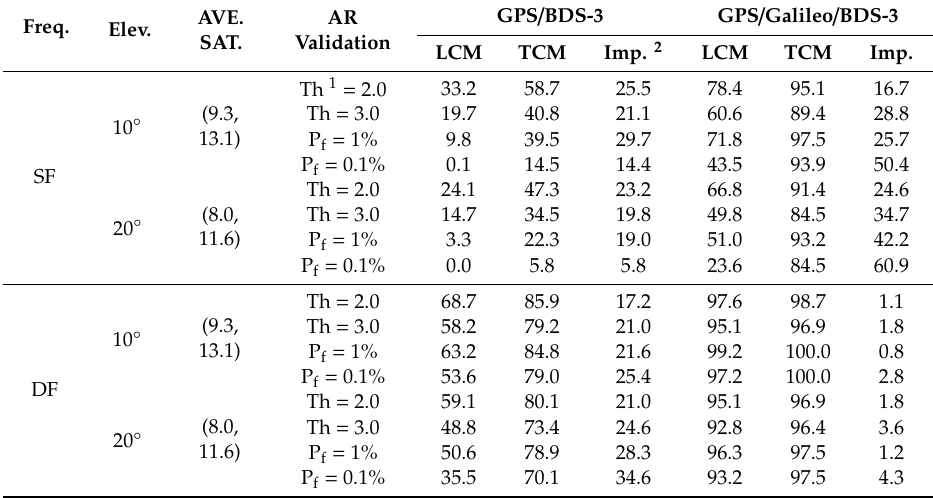
Table 5. Empirical ambiguity resolution success rates (percent) for GPS / BDS-3 and GPS / Galileo / BDS-3 solutions with 10 ◦ and 20 ◦ elevation cut-o ff angles. Freq. Elev. AVE.